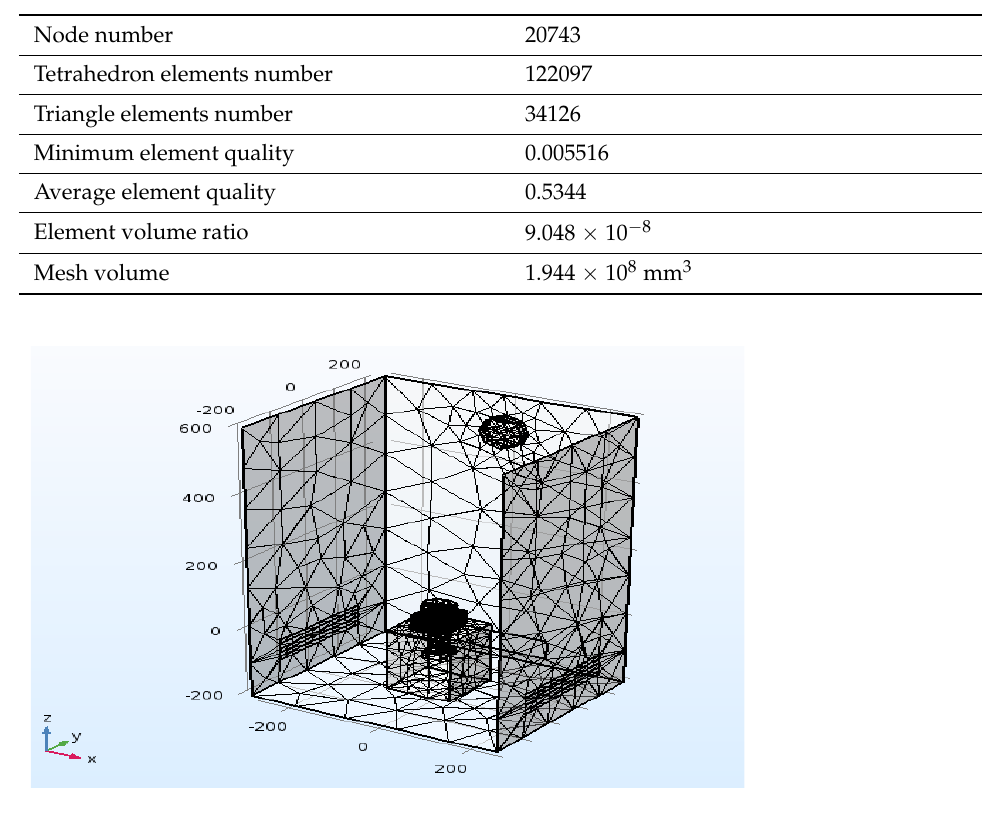
Figure 3. Mesh of numerical model.